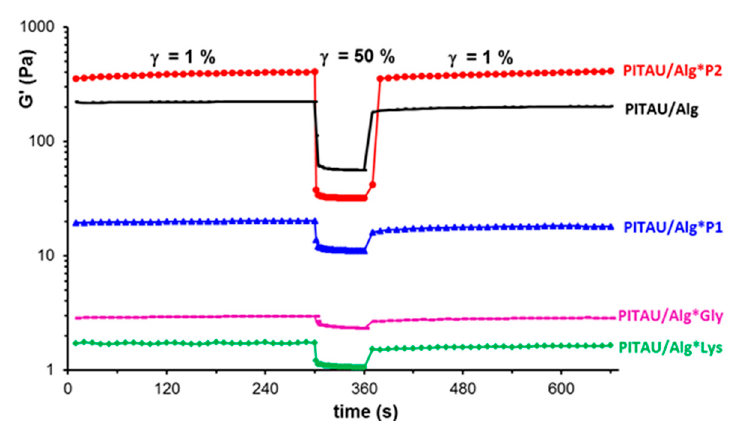
Figure 6. Illustration of the self-healing behavior through the dependence of G ′ as a function of time during consecutive step strain measurements at low (1%), high (50%), and low (1%) values of deformation ( γ ).